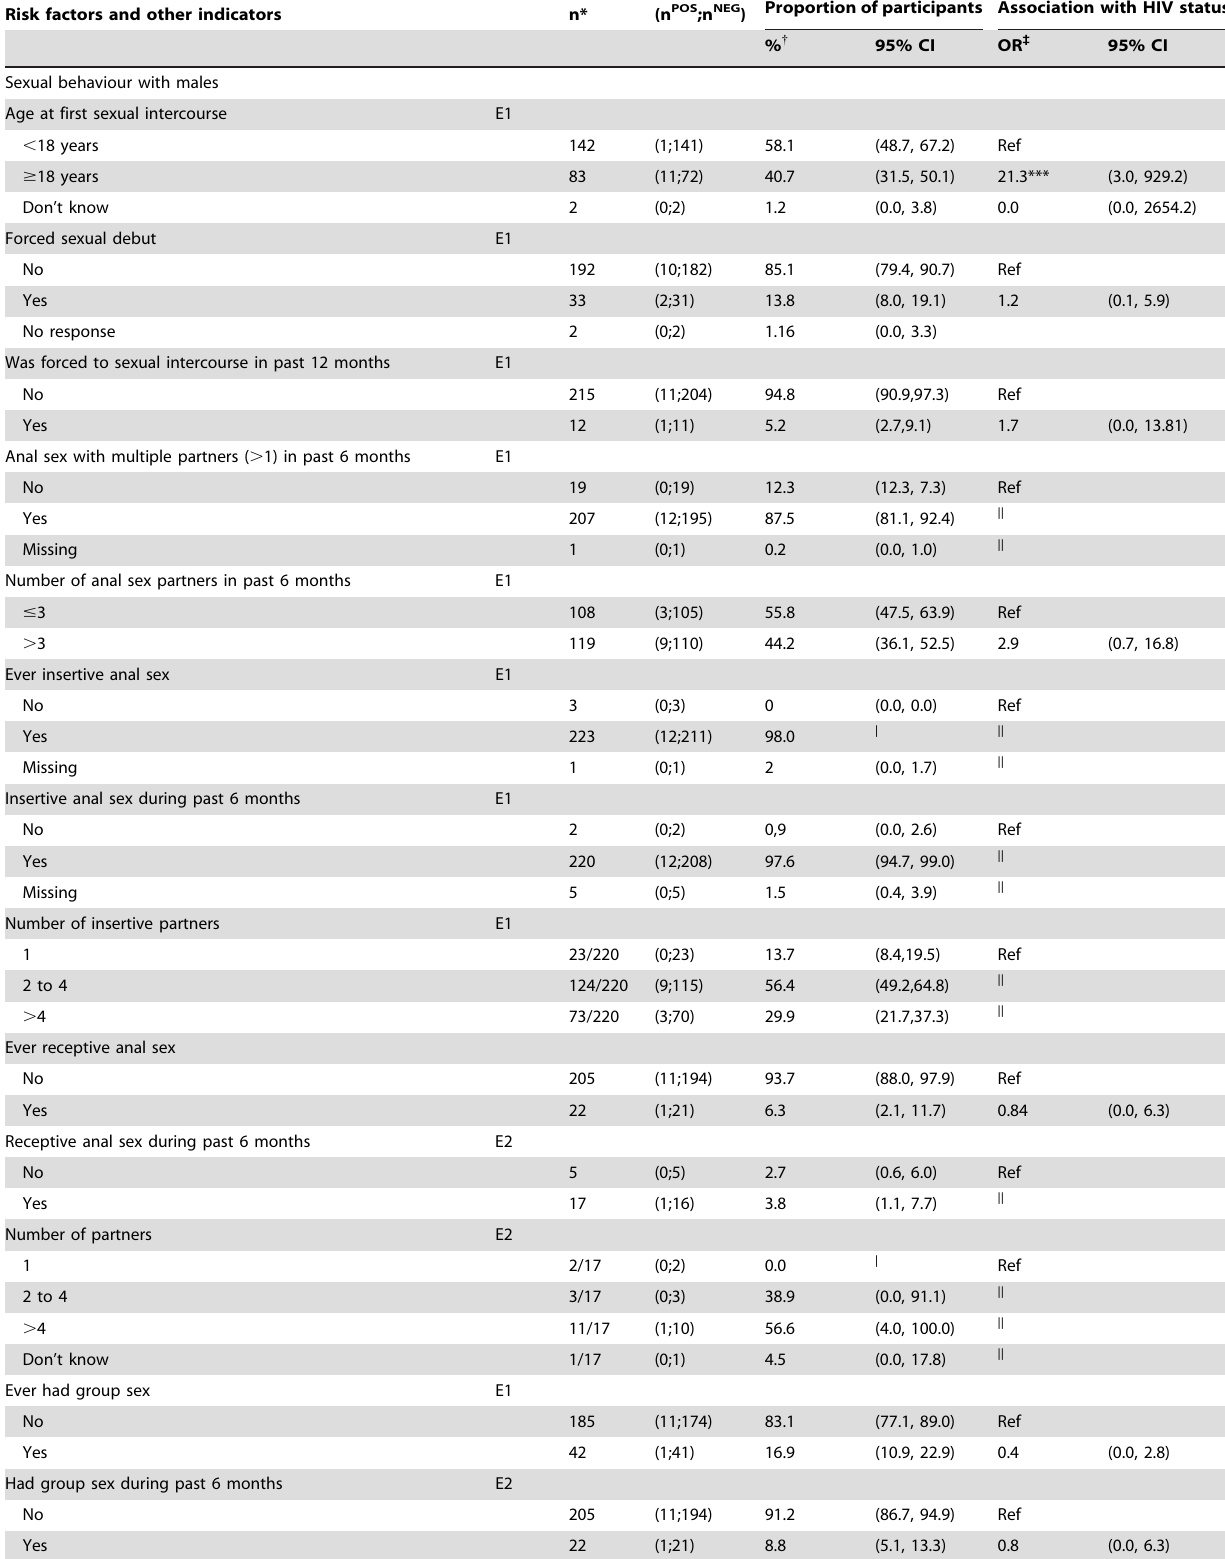
Risk factors and other